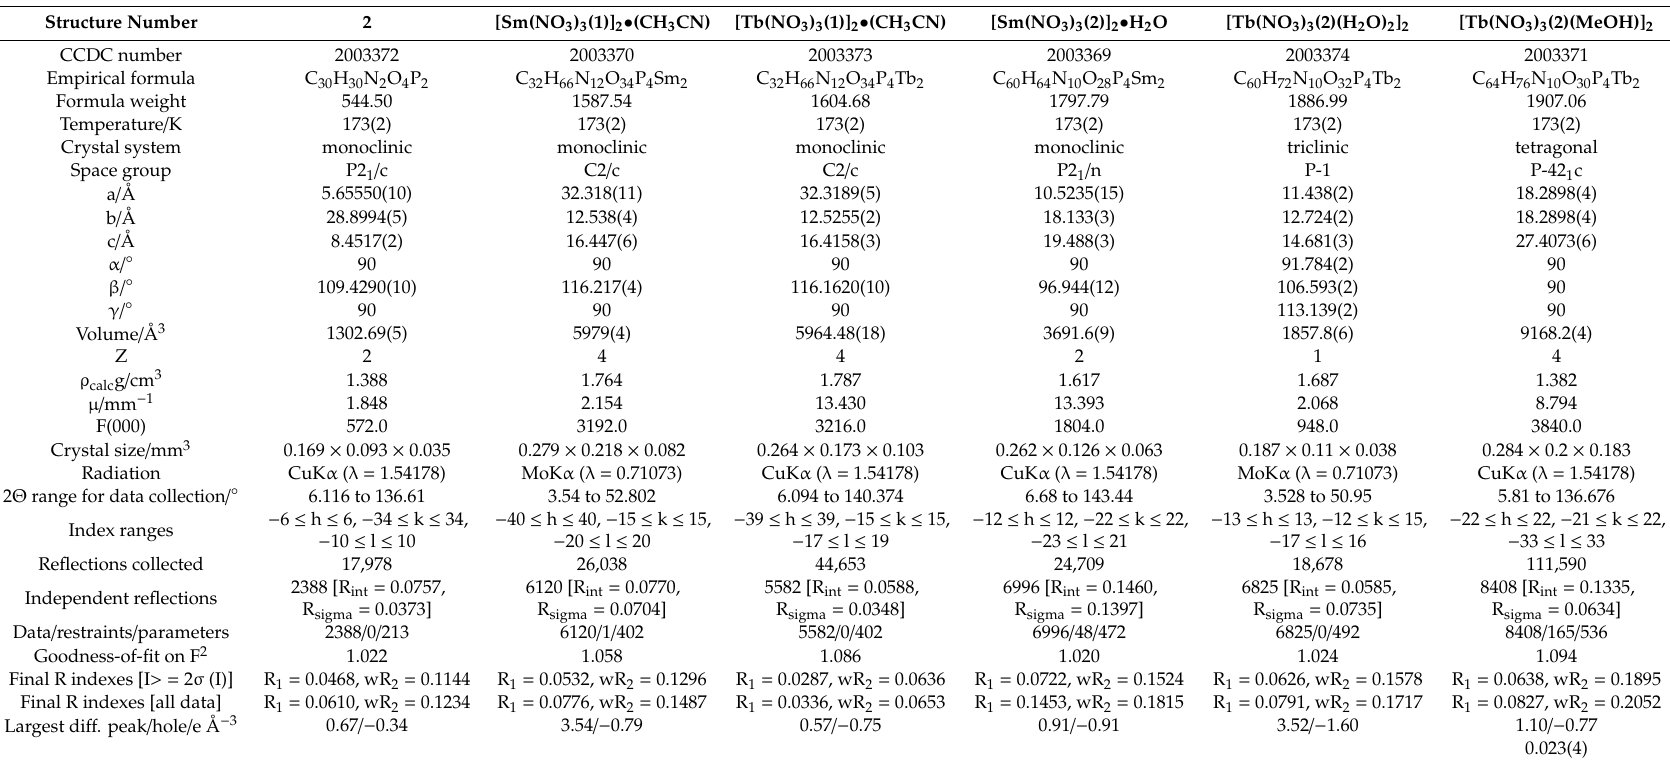
Table 2. Crystal data and structure refinement for free ligand 2 , and the metal complexes [Sm(NO 3 ) 3 ( 1 )] 2 • (CH 3 CN), [Tb(NO 3 ) 3 ( 1 )] 2 • (CH 3 CN), [Sm(NO 3 ) 3 ( 2) ] 2 • H 2